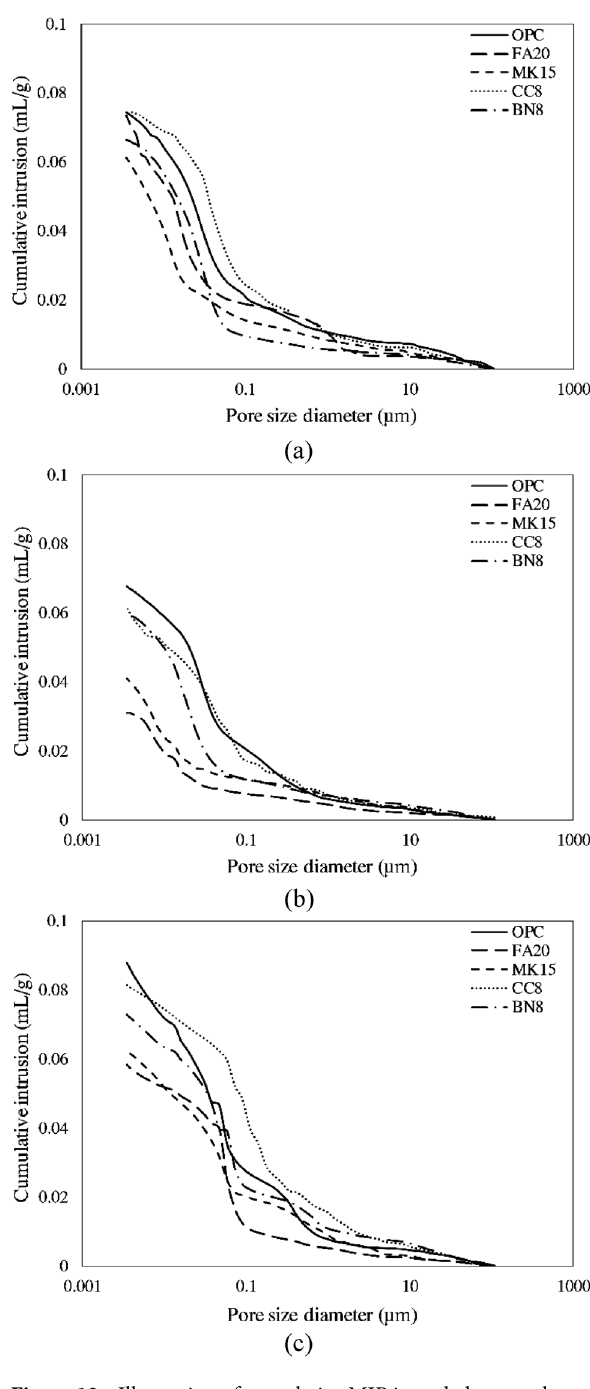
Figure 12. Illustration of cumulative MIP intruded pore volume versus pore diameter for cracked specimens: ( a ) at 28-day, ( b ) after 1-year of water submersion, and ( c ) after 1-year of cyclic T and